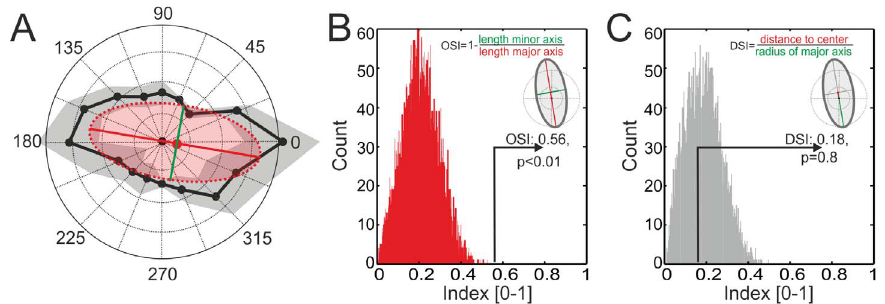
Figure 5. Example of an orientation-selective neuron. A . The polar plot in A shows the mean response (black dots) in response to the moving gratings (n=3) with the standard deviation being shown by the grey shaded area. The neuron was selective for motion in almost horizontal directions (e.g., moving gratings with vertically oriented stripes). The red dotted ellipse shows the fit to the raw data with the major and minor axis of the ellipse depicted by the red and green line. Note that the centre of the ellipse (red dot) is only shifted slightly off origin (black dot), which indicates very weak direction selectivity at most. In contrast, the major and minor axes differ markedly in their length, indicating a strong orientation preference of this cell. Direction selectivity was quantified by the DSI, defined as the metric distance of the centre of the ellipse from the centre of the coordinate system, relative to the radius of the major axis of the ellipse (see Methods and inset in C ). Orientation selectivity was quantified by the OSI=1 2 (minor axis/major axis) (see A and inset in B ). B, C . A Monte-Carlo approach was applied to test the robustness of the calculated OSI and DSI values. In each case the distribution of the indices obtained for 10.000 repetitions is shown, with the experimentally determined OSI and DSI values being superimposed by solid lines. Note that orientation preference was highly significant, whereas no directional preference was present. Rayleigh statistics confirmed the lack of directionality tuning of this neuron.